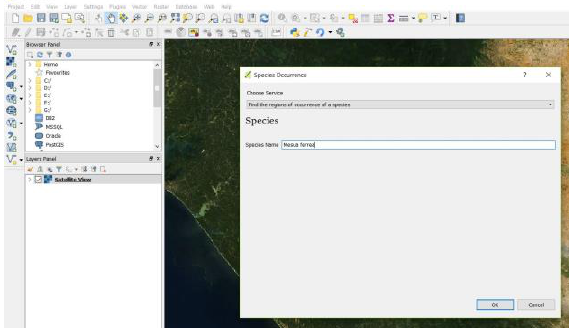
Figure 6. QGIS Plugin for IBIN Species Occurrence WPS Service